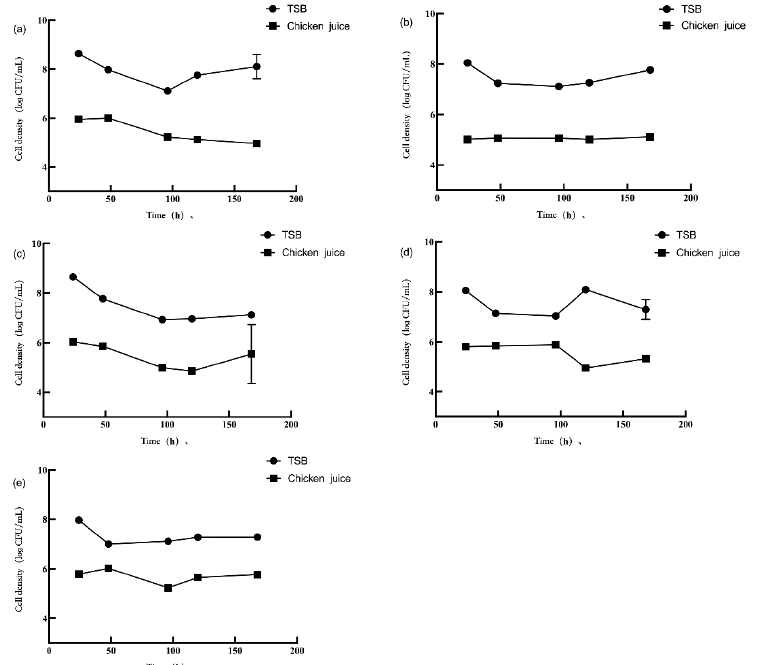
Figure 3. The planktonic population of L. monocytogenes ( a – e ) in different incubation conditions. Note: The mono-species suspension of L. monocytogenes biofilms with the initial inoculum concentration of 3 log CFU/mL ( a ) and 4 log CFU/mL ( b ); the dual-species suspension of L. monocytogenes and P. aeruginosa biofilms with the ratio 1:1 ( c ); 1:10 ( d ); and 10:1 ( e ). Foods 2022 , 11 , x FOR PEER REVIEW